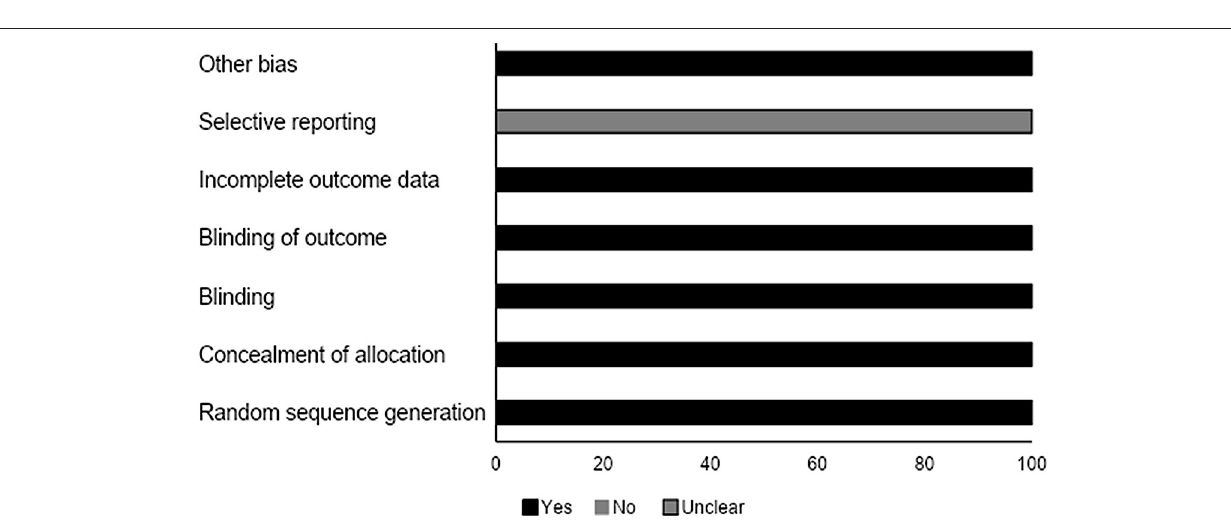
Selective Other Blinding Blinding of Incomplete reporting outcome outcome data